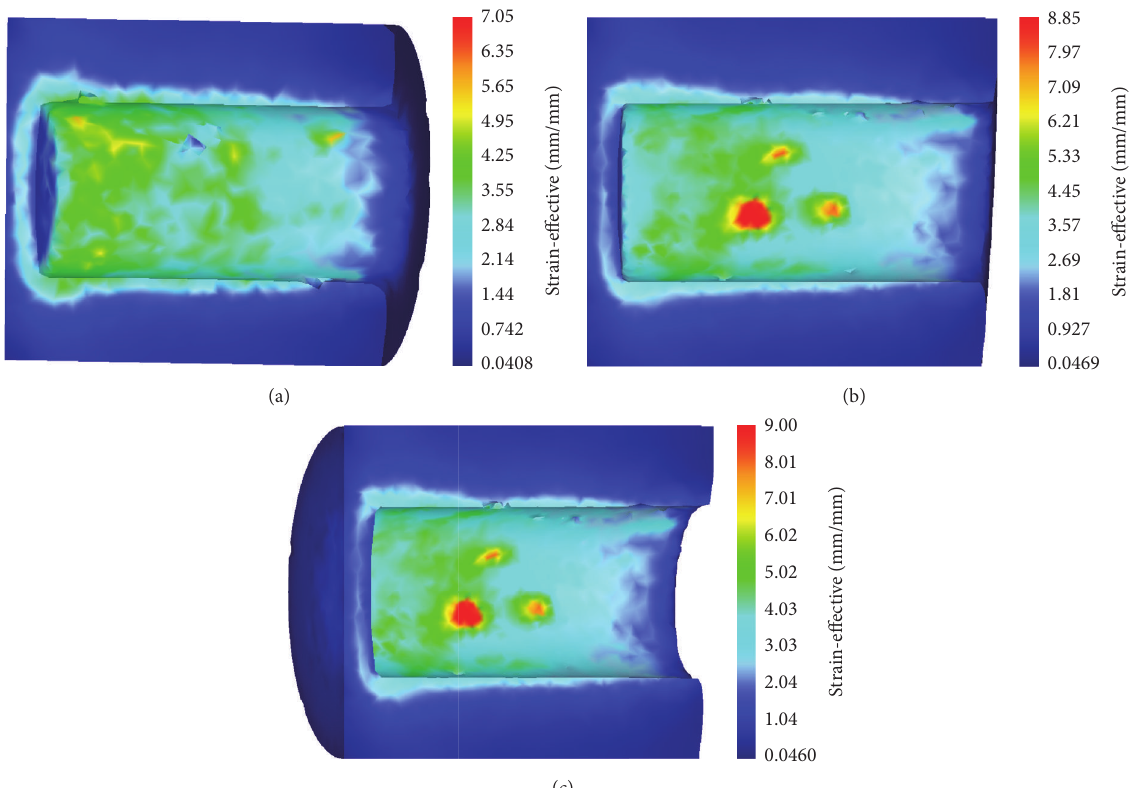
Figure 10: Strain field distribution of billet deformed at the piercing speed of (a) 50 mm/s, (b) 80 mm/s, and (c) 100 mm/s.